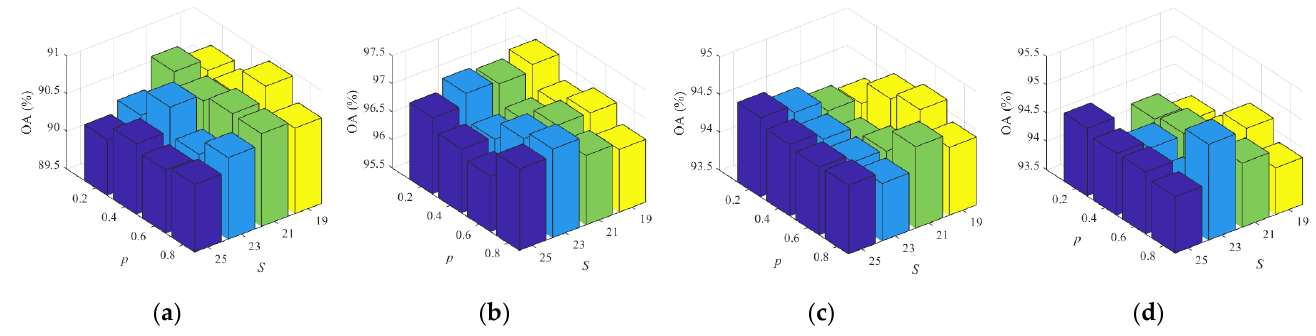
Figure 23. Classification accuracies over different values of 𝑝 and 𝑆 : ( a ) Indian Pines dataset; ( b ) Pavia University dataset; ( c ) Houston dataset; ( d ) Chikusei dataset.